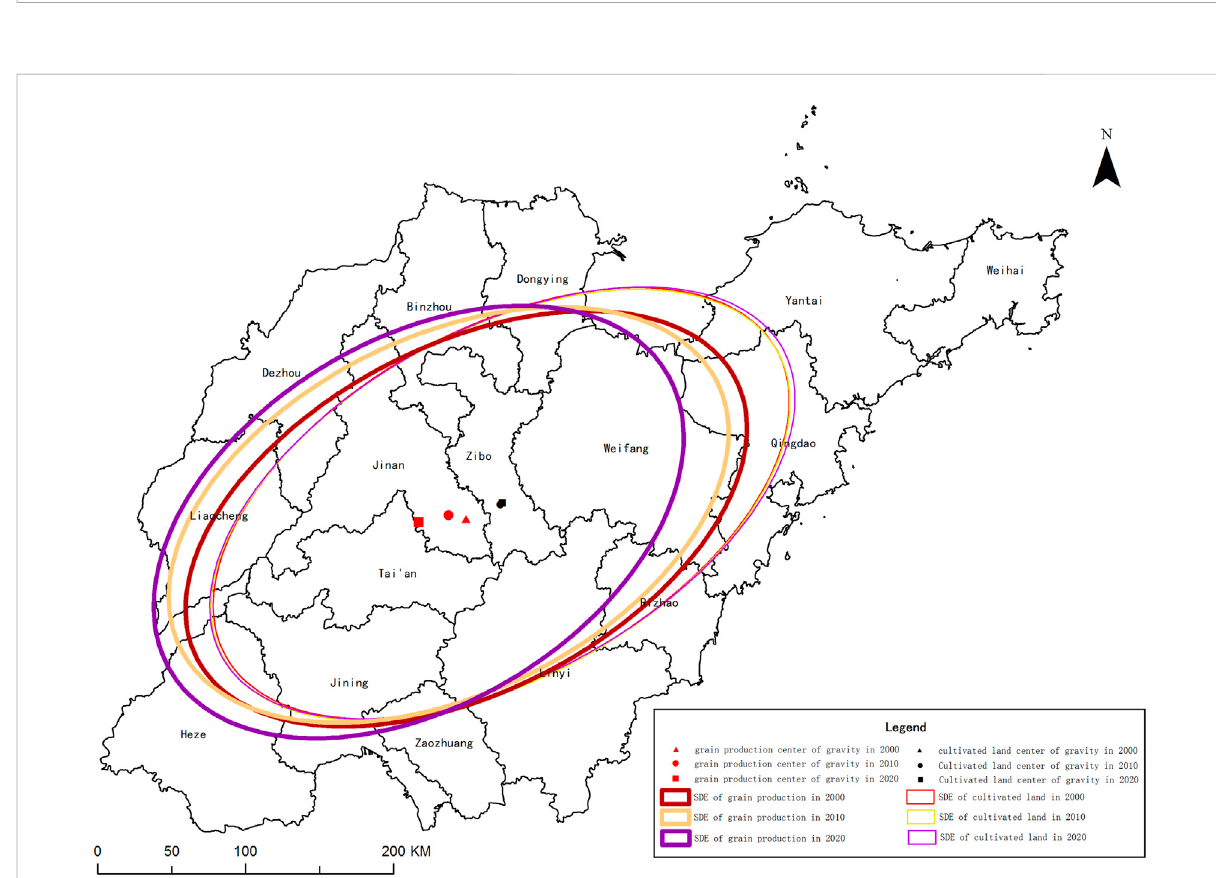
FIGURE 5 Barycenter and standard deviation ellipse of cultivated land and grain